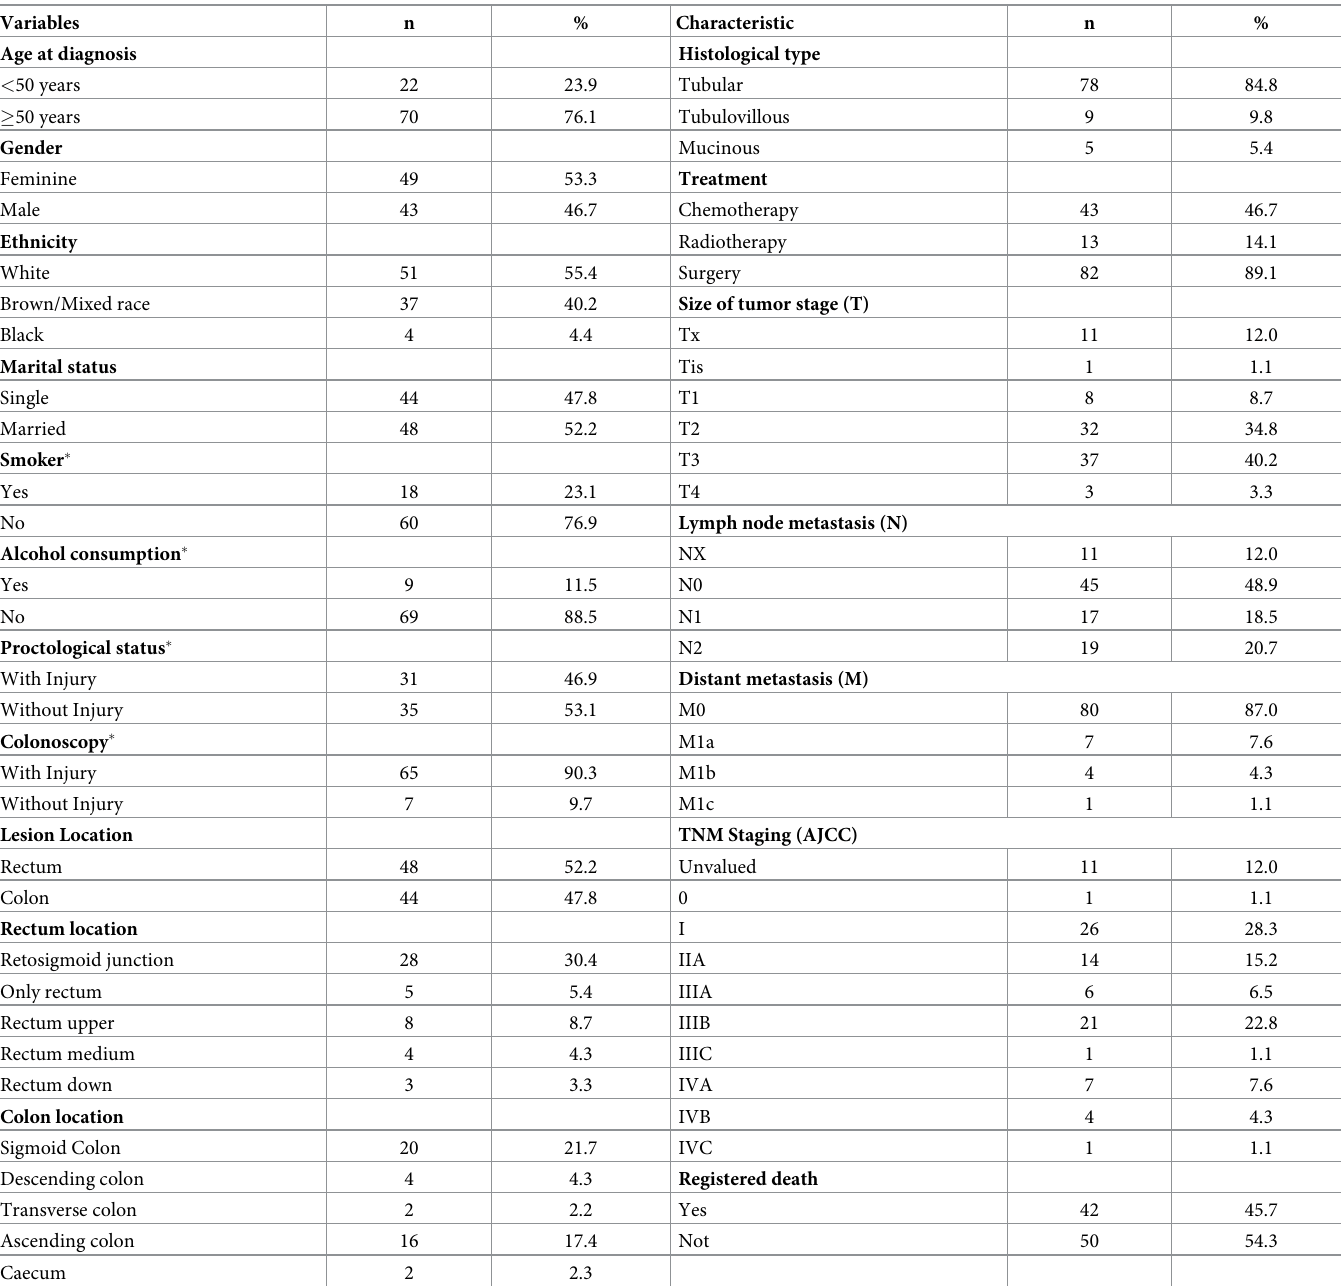
Table 1. Sociodemographic, clinical and pathological data of 92 participants with colorectal cancer.